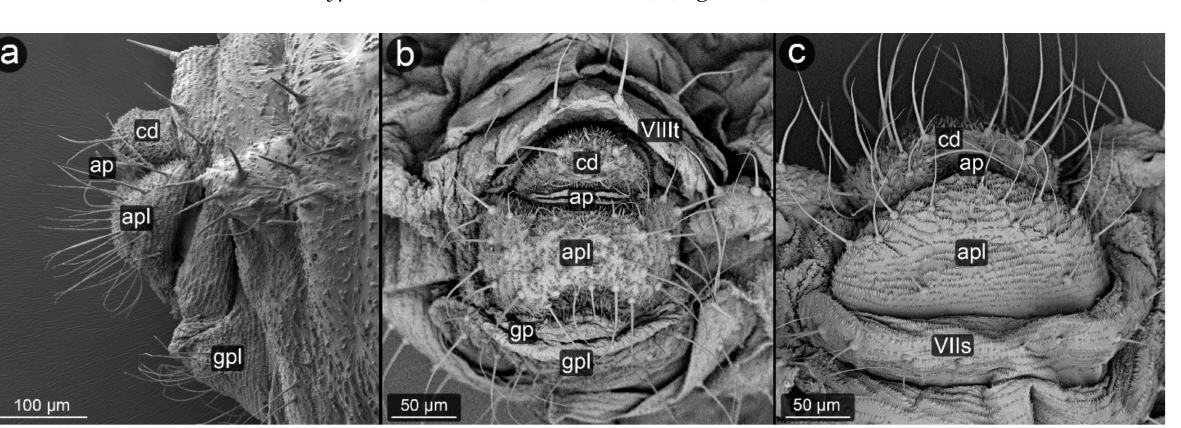
Figure 3. Perianal structure of Glyphina betulae in SEM; ( a )—lateral view, ( b )—rear view, ( c )— abdominal view (VIIIt—abdominal tergite VIII, VIIs—abdominal sternite